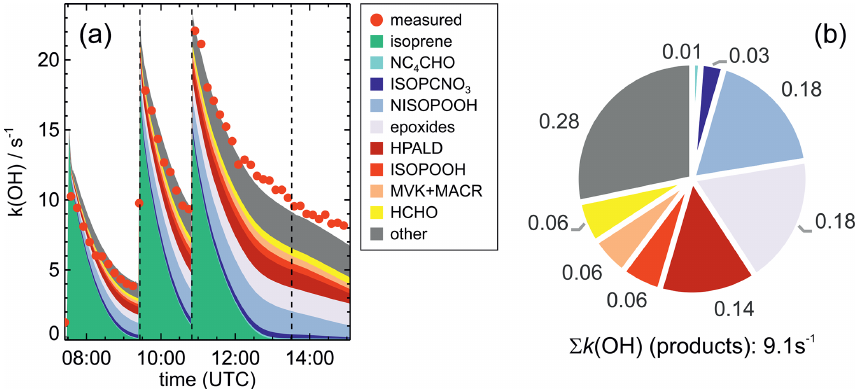
Figure 9. Comparison of measured OH reactivity from organic compounds and OH reactivity (a) calculated from concentrations of organic compounds modelled applying the FZJ-NO3 chemical mechanism for the experiment on 13 August 2018 (Experiment 4). The reactivity from nitrated and non-nitrated hydroperoxide compounds (NISOPOOH, ISOPOOH) is partly invisible for the laser photolysis LIF instrument because these species produce OH radicals after reacting with it. The OH yield is rather uncertain but is expected to be less than 10%, for example in the Caltech mechanism. In addition, the relative distribution of OH reactivity from organic products is shown (b) . OH reactivity from organic compounds is derived by subtracting the reactivity via NO 2 and O 3 calculated using measured concentrations from the measured total OH reactivity. “Other” compounds include a high number of organic compounds that are produced in the reaction of isoprene with OH, O 3 and NO 3 and for which loss by the reaction with OH is implemented in the FZJ-NO3 mechanism. Dashed vertical lines indicate times when isoprene, NO 2 and O 3 were re-injected. The last injection included only NO 2 and O 3